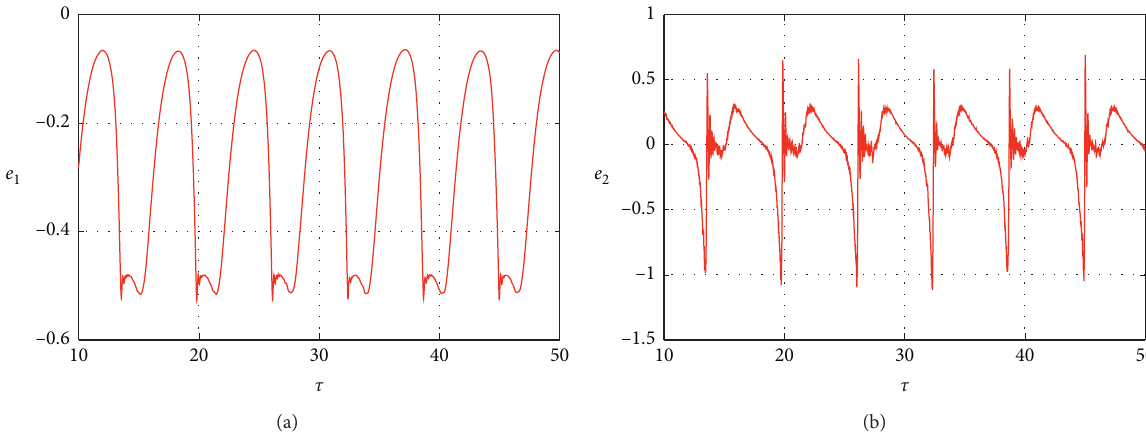
Figure 12: Deviation of the desired trajectory with the proposed control with parametric errors in feedback control ( 􏽥 u ) by OLFC and feedforward control. (a) Deviation of the desired trajectory e 1 ; (b) deviation of the desired trajectory e 2 .